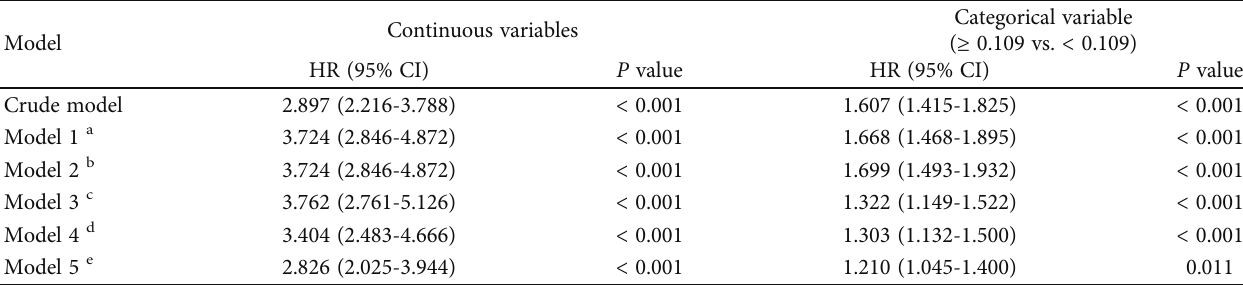
Table 3: Risk of 28-day mortality in patients with sepsis according to red cell distribution width to platelet ratio.